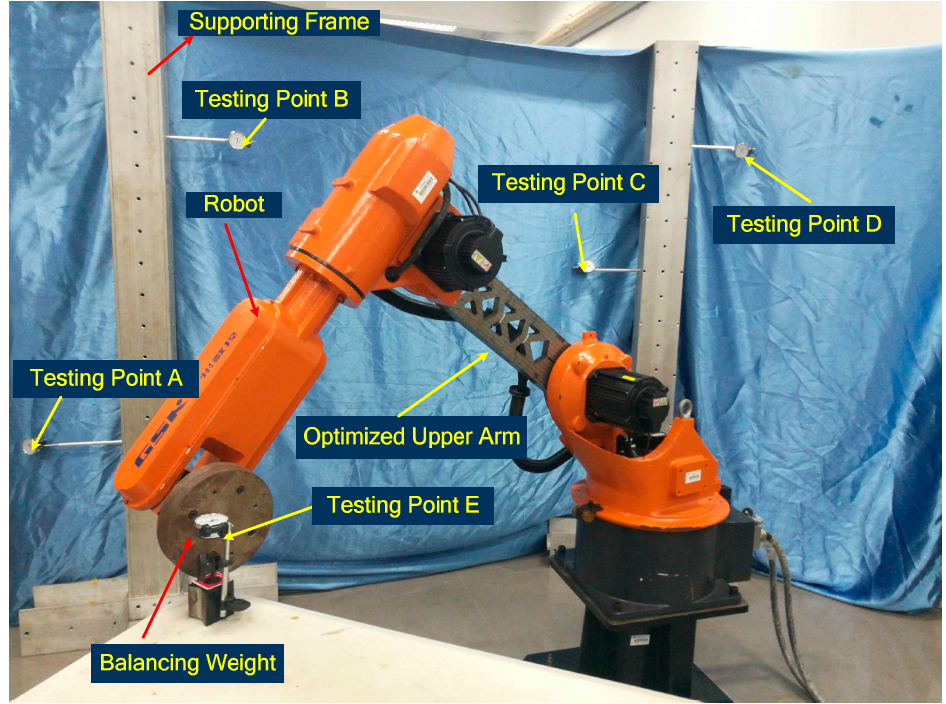
Figure 28. A self-designed experimental platform and testing point.